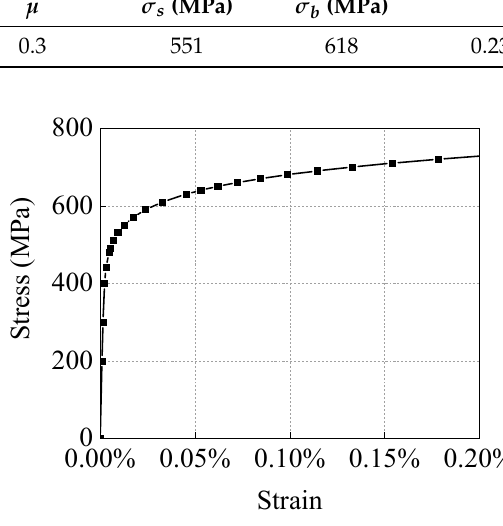
Table 2. X65 mechanical parameters of X65 pipeline steel.